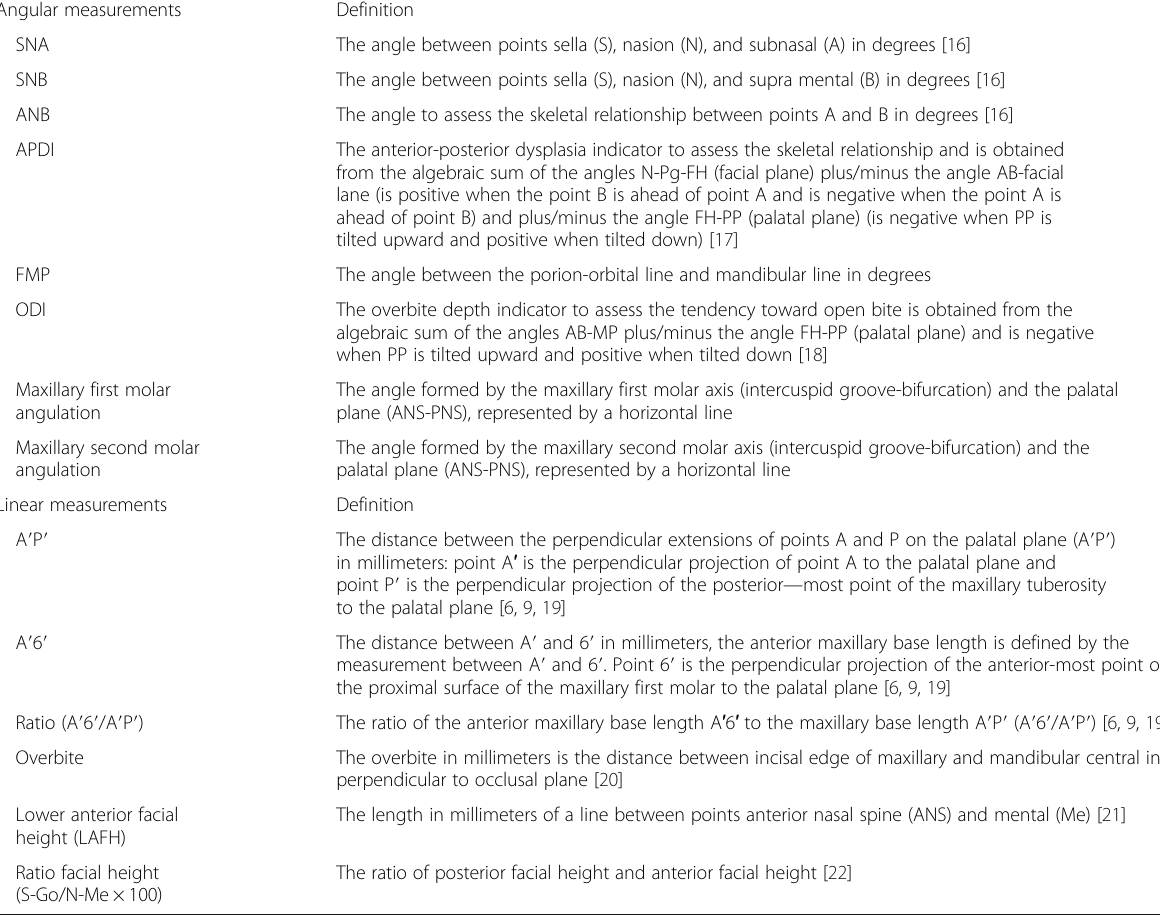
Table 2 Definitions of cephalometric points and angles used in this